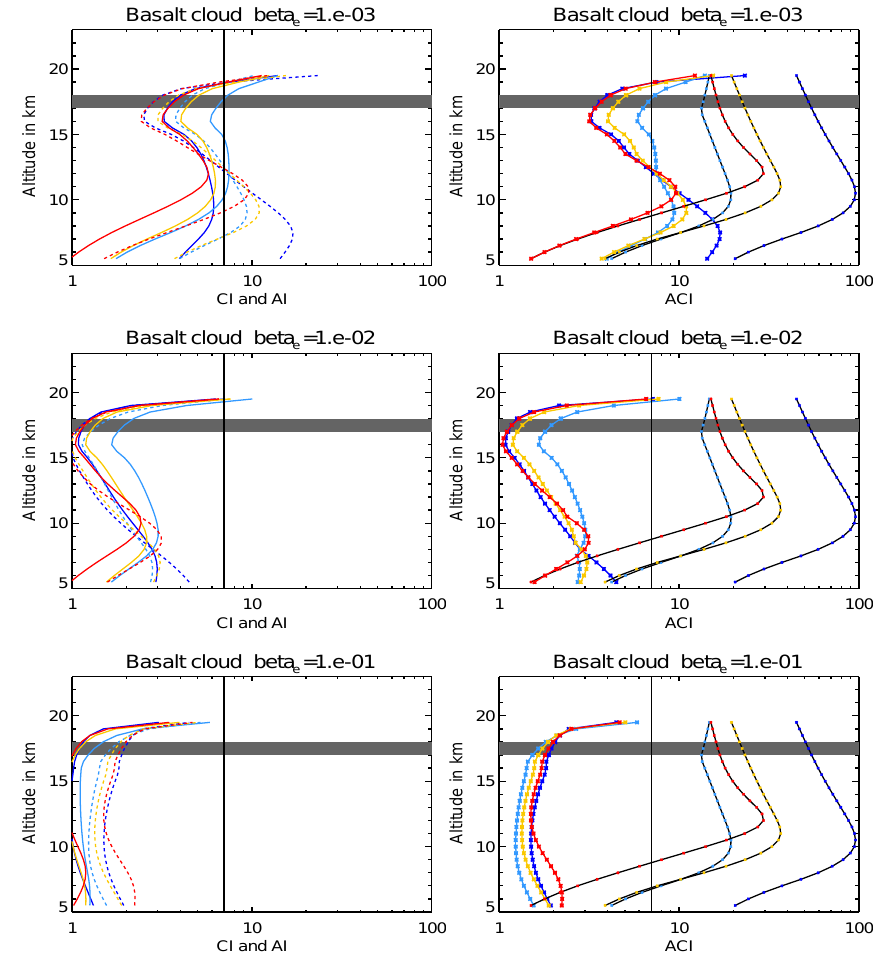
Figure A6. Same as Fig. A5 but for volcanic ash and the mode radius of